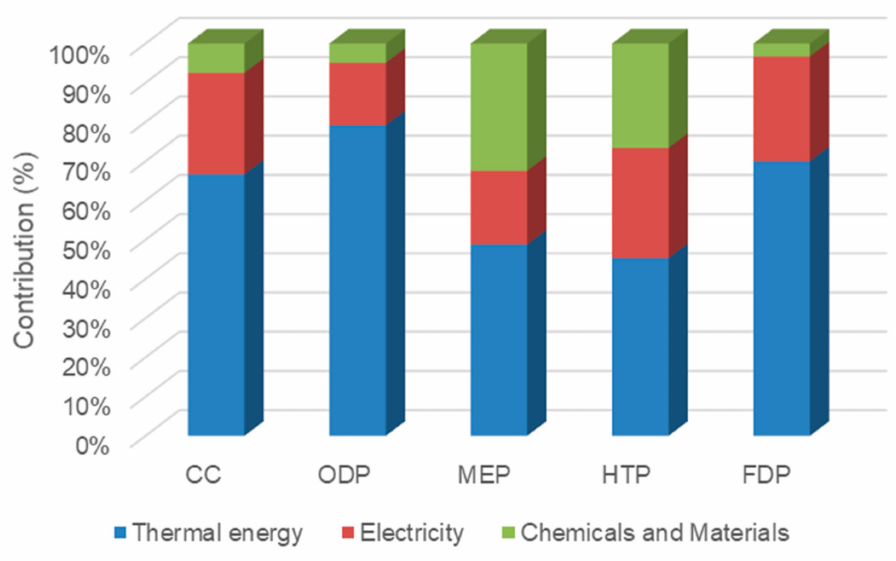
Figure 8. The contribution of inventories in midpoint impacts of case